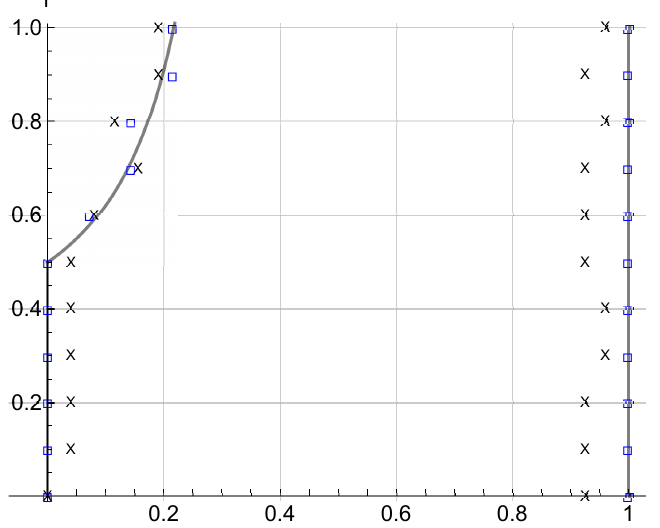
Figure 10. Coupling between the first and second modes. = model solution; (cid:3) = FEM simulations; × = experimental